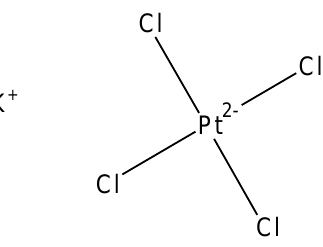
Figure 9. Potassium tetrachloroplatinate